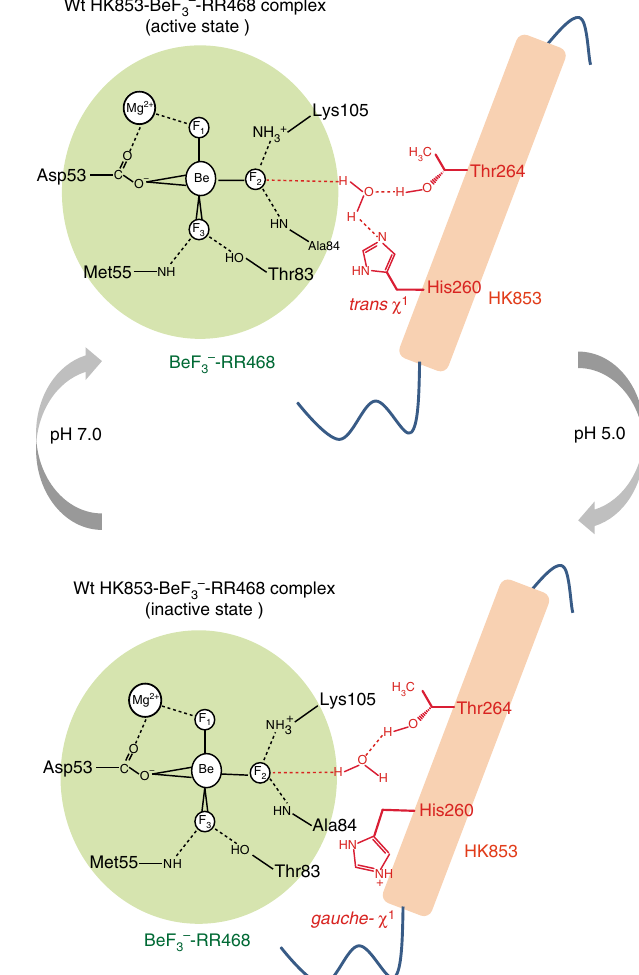
the mRNA levels of ssrA and ssrB in the envZ-T247A mutant strain de fi cient in the phosphatase activity are enhanced in comparison to those in the wild-type EnvZ strain, the variation in the mRNA levels of ssrA and ssrB under different pH observed changes in the mRNA levels of ssrA and ssrB under the